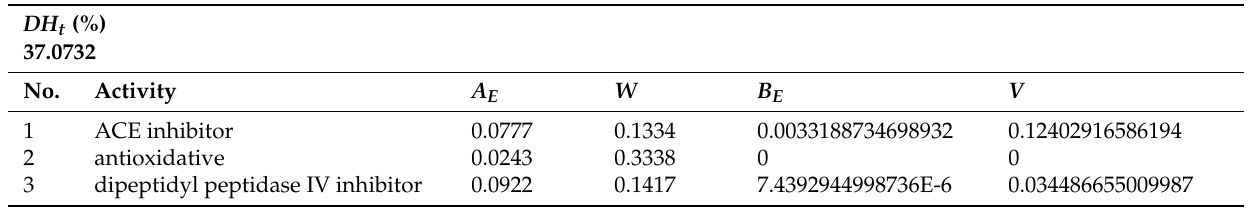
Table A8. A E , DH t , W , B E and V values from RubisCO of Halophila stipulacea . In silico enzymatic cleavage was carried out by proteinase K.